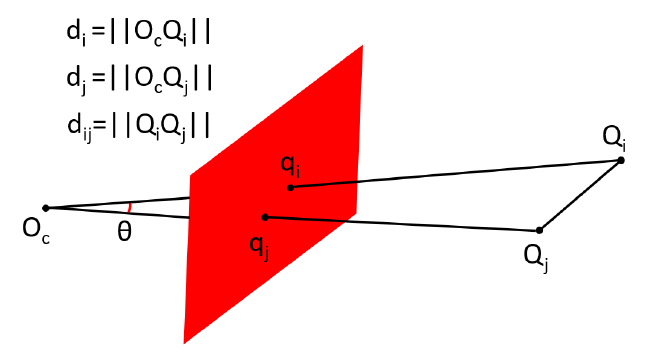
Figure 5. Constraint given by Equation